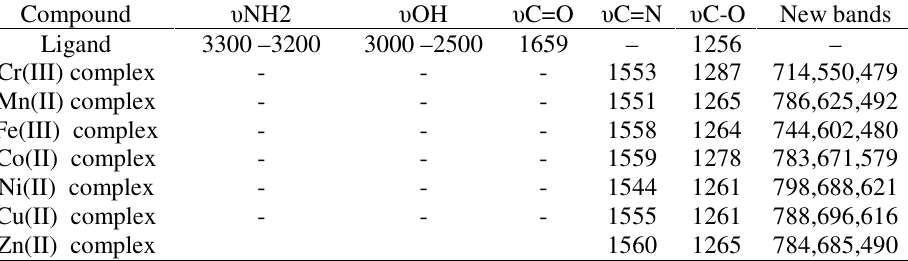
Table 2. Characteristic infrared frequencies of the complexes of H